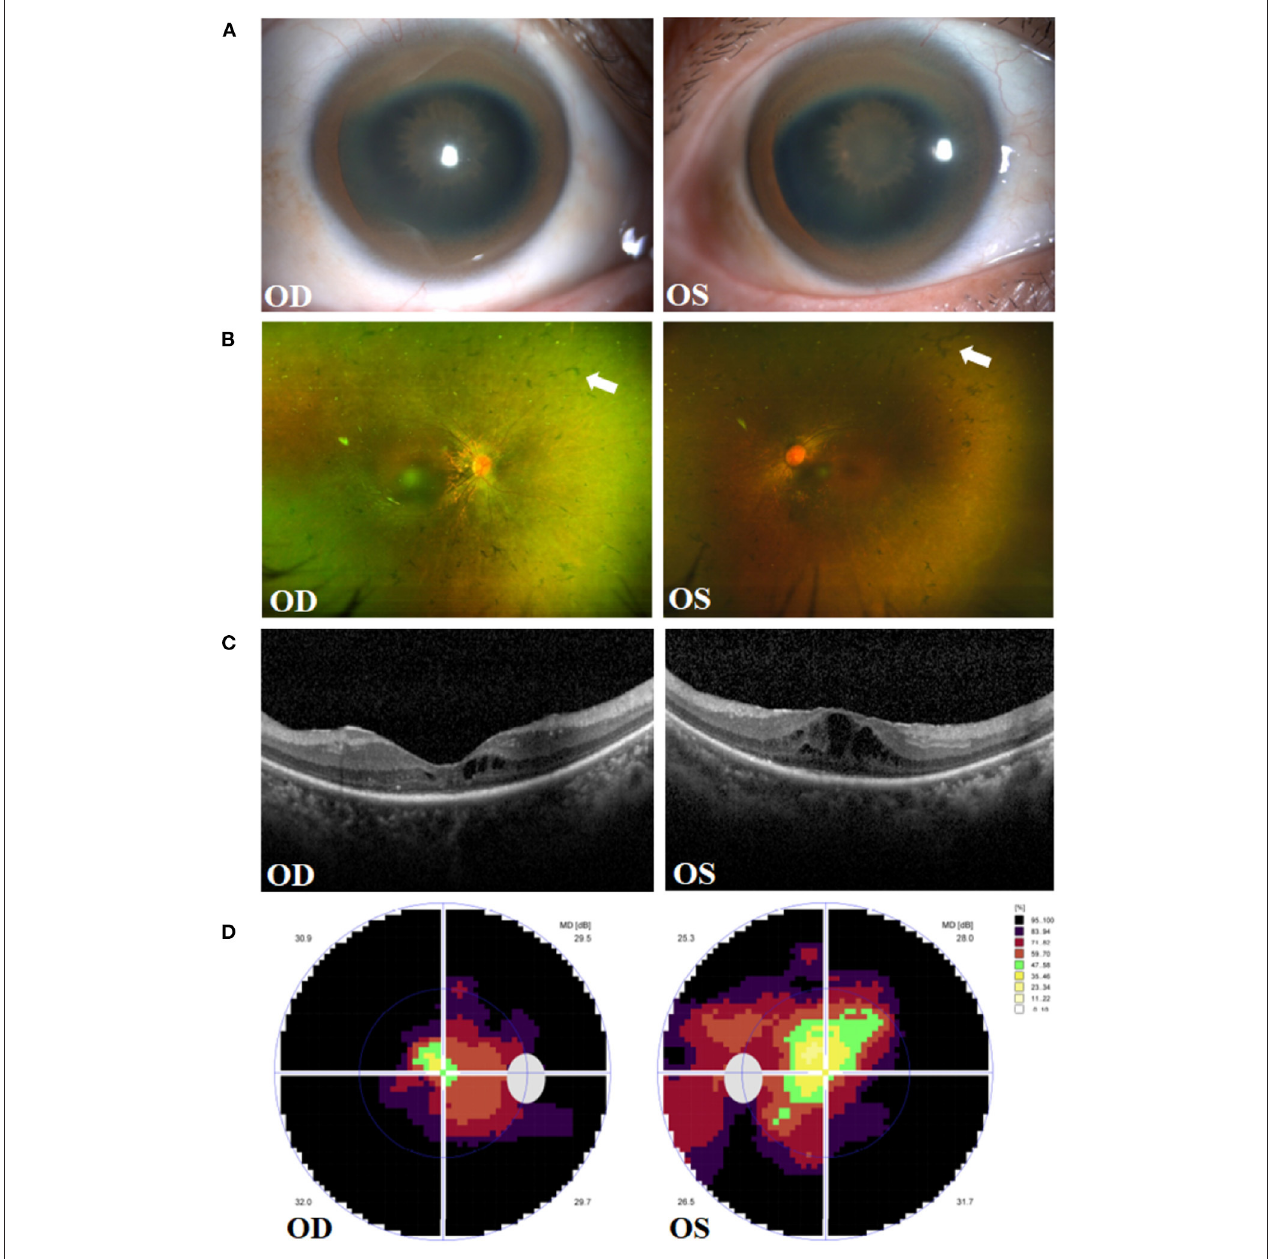
FIGURE 1 | Clinical presentations in the right eye (OD) and left eye (OS) of the patient. (A) Manifestation of Kayser-Fleischer (K-F) ring and sunflower-like cataract. (B) Fundus images of osteocyte-like pigmentation (white arrows) in bilateral retina. (C) Optical coherence tomography (OCT) showing outer retina atrophy and cystoid macular edema. (D) Vision detection featuring binocular tunnel